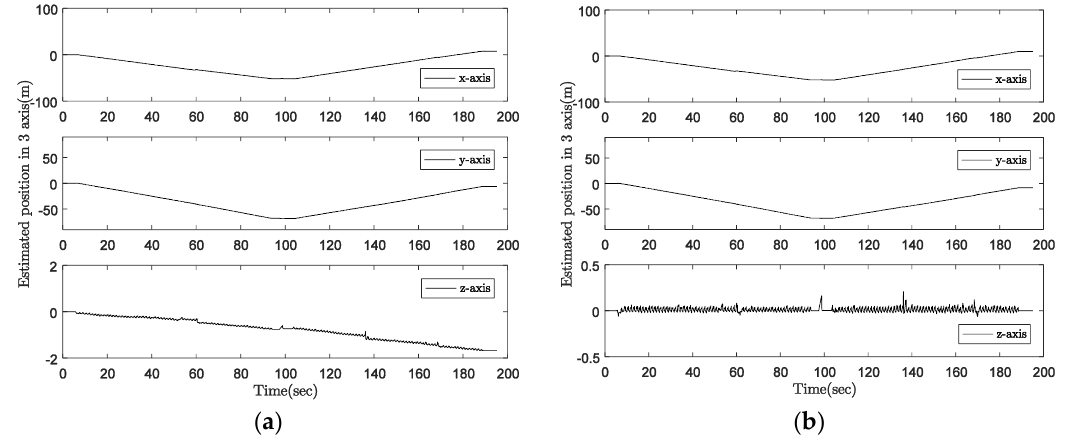
Figure 20. z -axis position estimation: ( a ) without z -axis updating; ( b ) with z -axis updating.